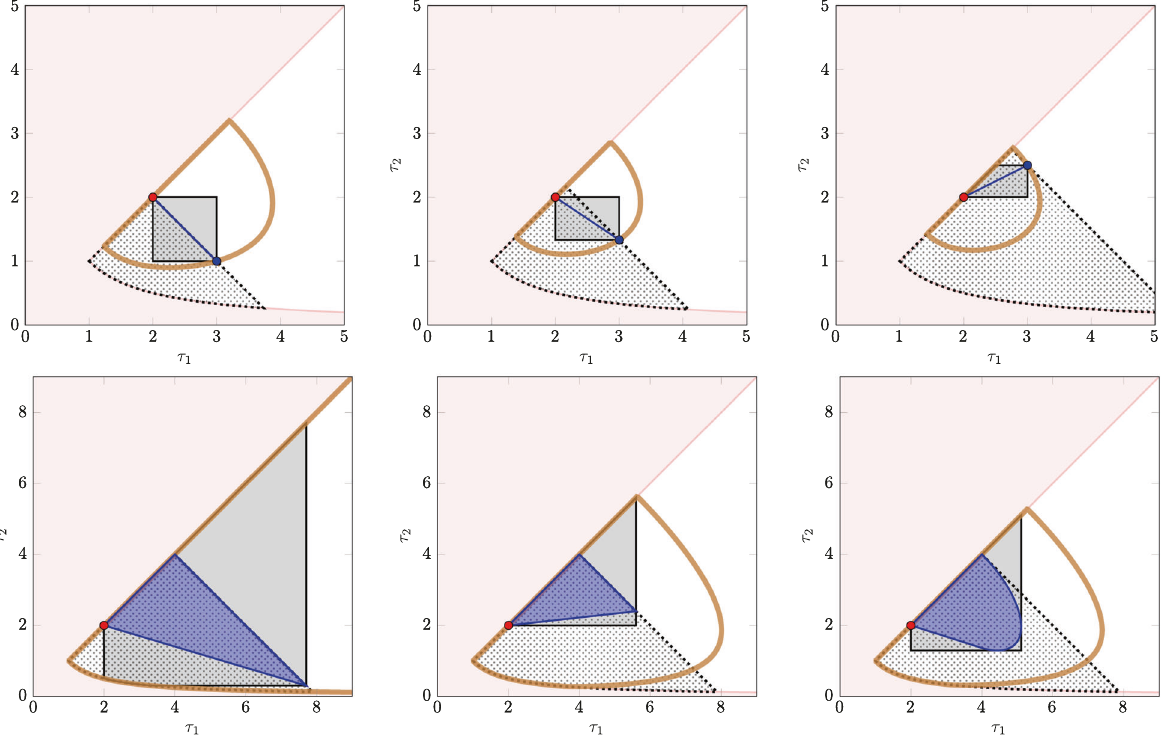
Fig. 5 Visualization of some of our thermodynamic laws. Each example in the top half is associated with a single-mode initial state (marked with a blue dot), while those in the bottom have two-mode initial states (details in Supplementary Note 6). The plot region contains potential single-mode states reachable from the given initial state, with the X axis parametrizing τ 1 (the fi rst principal directional temperature), and the Y axis τ 2 , of these states. The thermal state is marked with a red dot. The outer pink region marks unphysical states that must therefore be ignored. The blue-shaded region enclosed by solid blue lines depicts all the single-mode states accessible from the given initial state, found using brute-force numerical computation (feasible only in these simple cases): notice that this region shrinks to just a line for single-mode initial states. The gray-shaded region enclosed by solid black contains all fi nal states consistent with Theorem 1; the dotted region enclosed by the dashed black lines contains those consistent with Theorem 2; fi nally, the region enclosed by the solid yellow lines contains fi nal states allowed by the monotonicity of the generalized non-equilibrium Helmholtz free energy (i.e., relative entropy with respect to the thermal